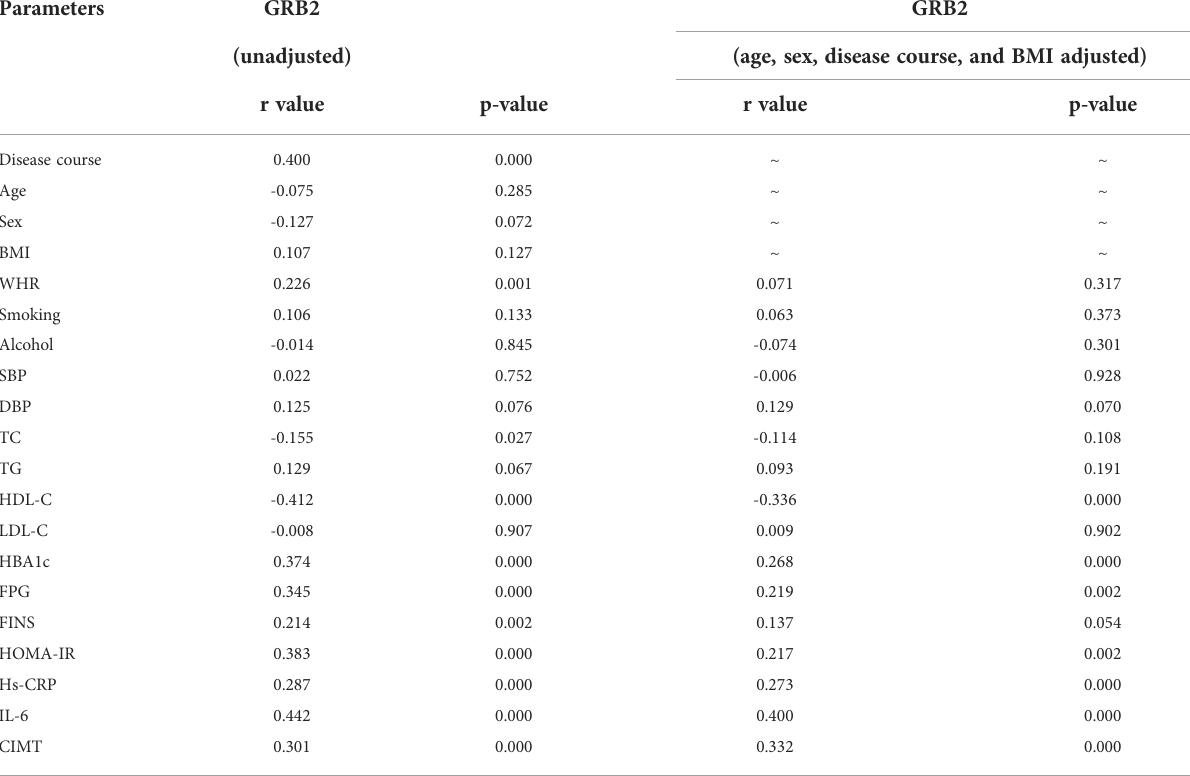
TABLE 3 Correlation analysis of variables associated with serum GRB2 concentration in the study population.